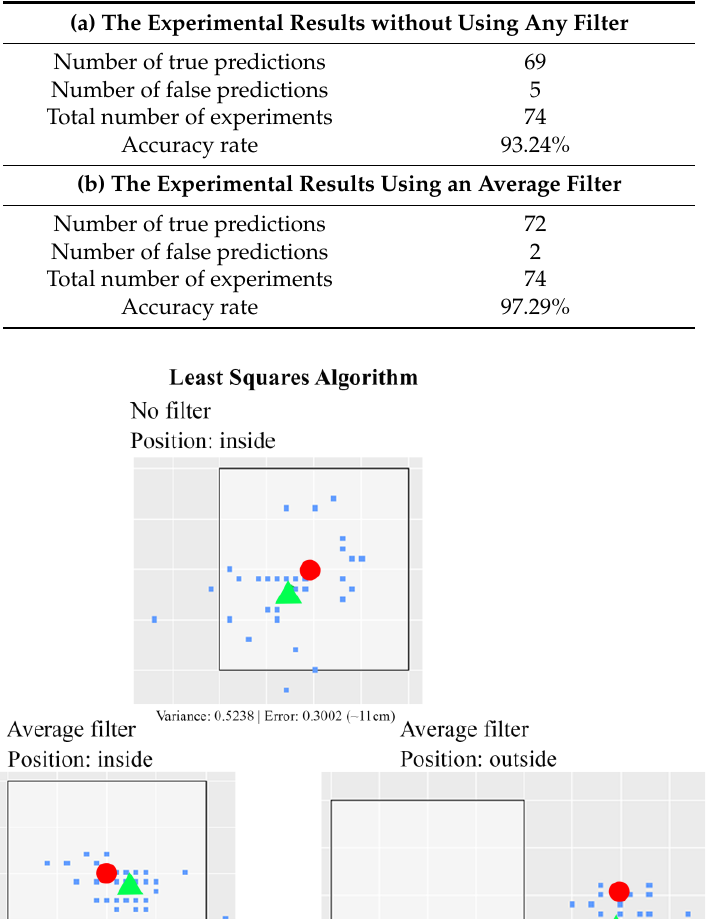
Table 3. A total of 148 experiments for indoor positioning detection using least squares algorithm.